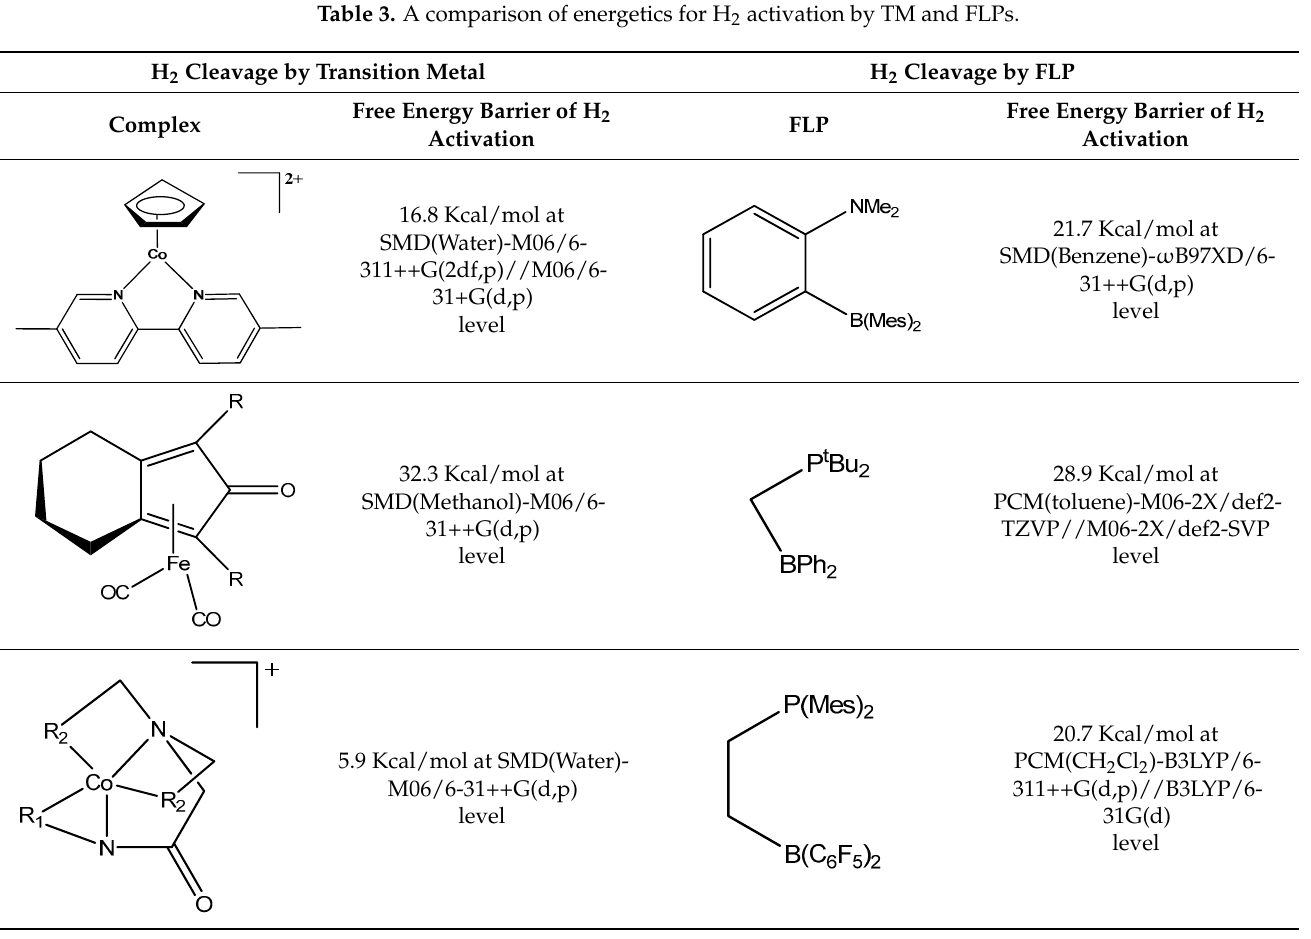
2 activation by TM and FLPs. Table 3. A comparison of energetics for H